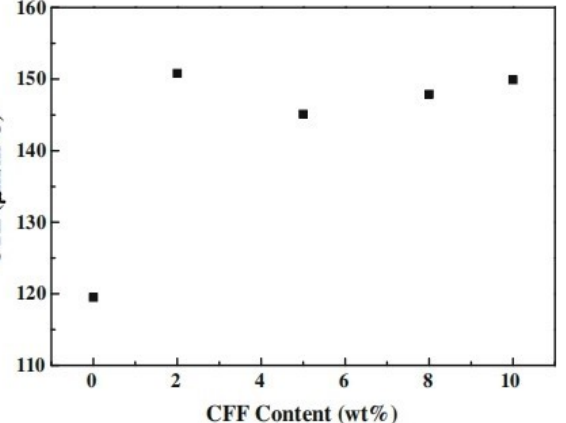
Figure 7. Plot of coefficient of thermal expansion for pure PLA and CFF/PLA composites with different CFF contents. (Reproduced with a copyright permission from Cheng et al. [133]).